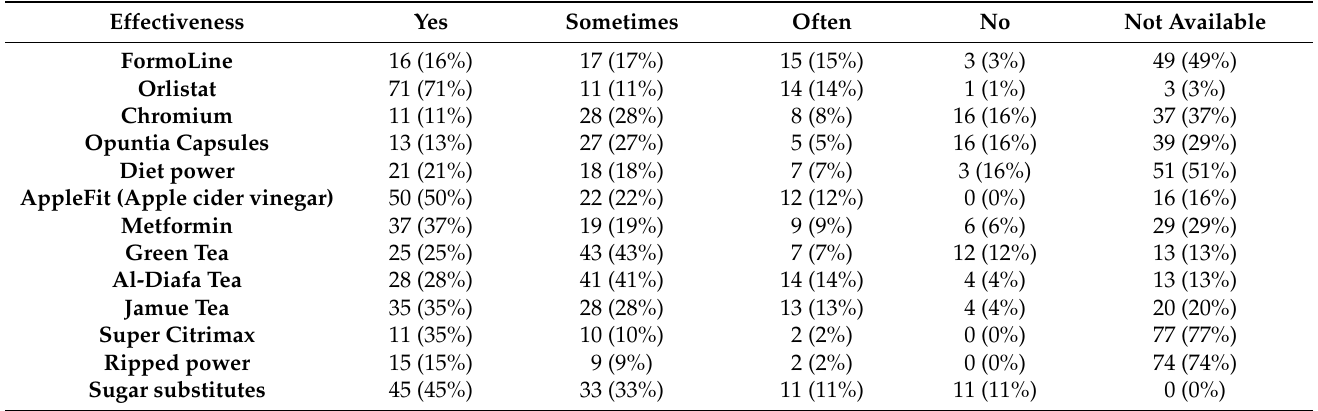
Table 3. Effectiveness of weight loss products according to